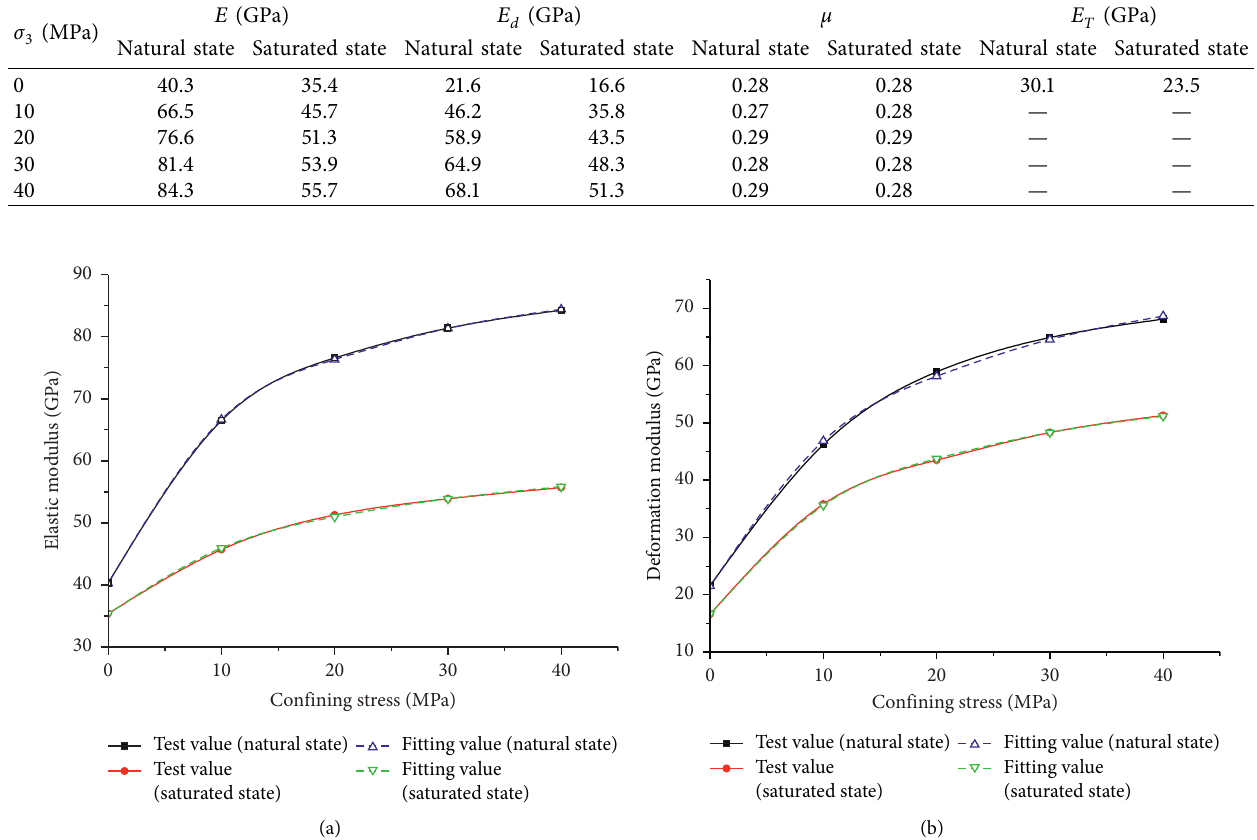
Table 2: Deformation parameters of Yunnan limestone under natural and saturated conditions.